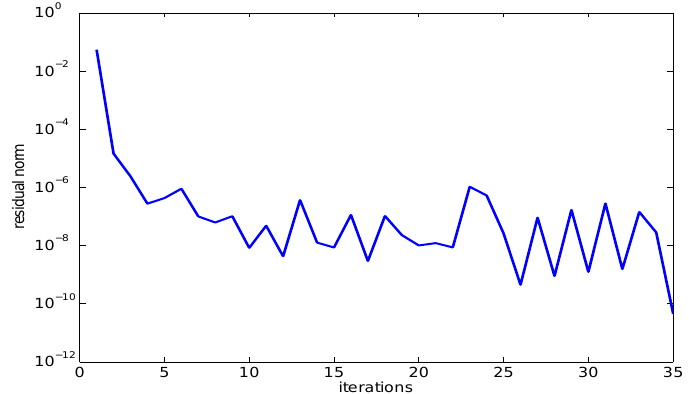
Figure 3. Convergence history: Jacobi–Davidson with block Cholesky preconditioner.